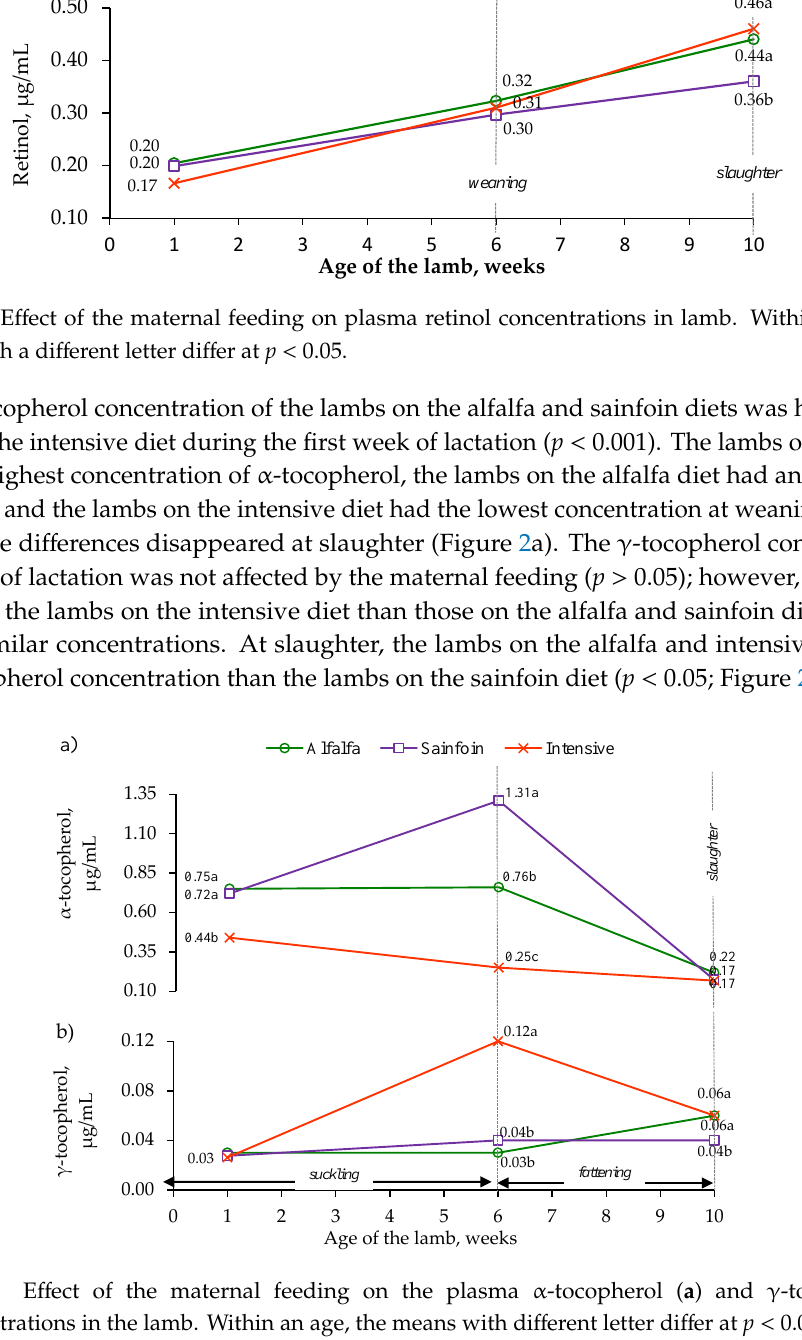
Table 2. Contents of carotenoids, tocopherols, total polyphenols and total condensed tannins (CT) in the feedstuffs of the ewes and the concentrates of the lambs.